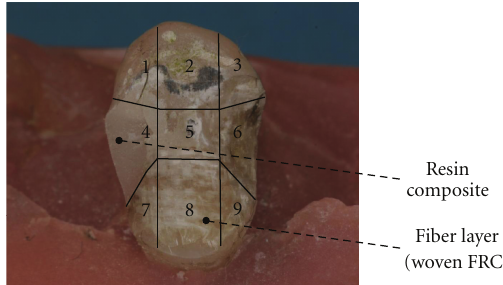
Figure 2: Example of specimen before repair with areas for repair surface evaluation. Surface areas 1–3 include the palatal cusp; 4 and 6 include the mesial/distal box; 5 includes the step; 7–9 include the buccal